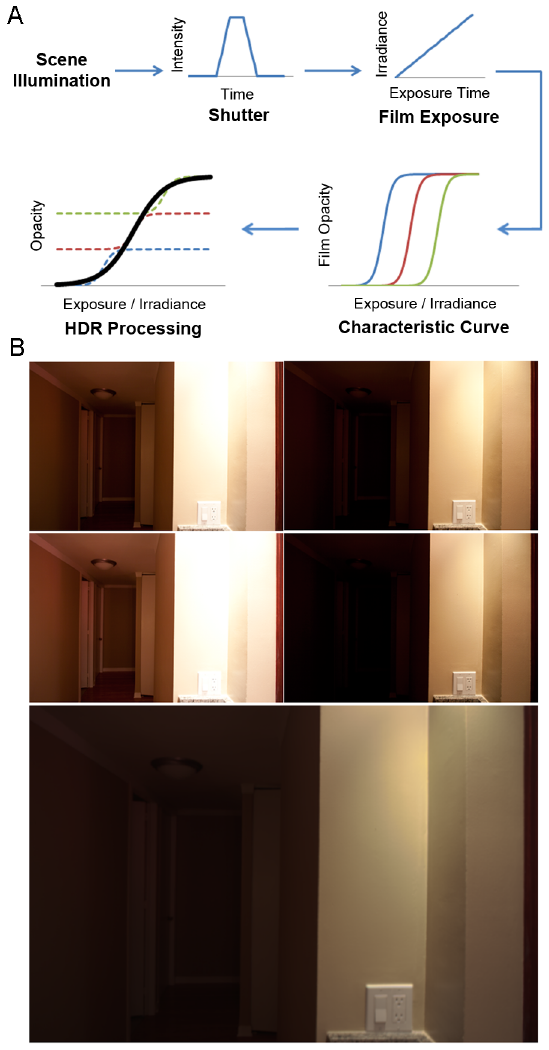
Figure 2. HDR processing in photography. (A) LDR photos taken at varying exposure times produce shifted characteristic curves (otherwise known as the digital conversion function f ) that cover different ranges of irradiance. HDR processing merges the LDR characteristic curves to produce an HDR characteristic curve that covers a larger range of irradiance. The HDR characteristic curve is used to calculate object illumination to alleviate the issues of over- and under-exposure associated with conventional LDR photography. (B) An example showing the merger of 4 LDR photos (smaller photos) to a HDR photo (larger photo). In the HDR photo, the front wall showed no saturation from over-exposure while the poorly lit hallway remained visible. This was not achieved in any single LDR photo due to the limited dynamic range.